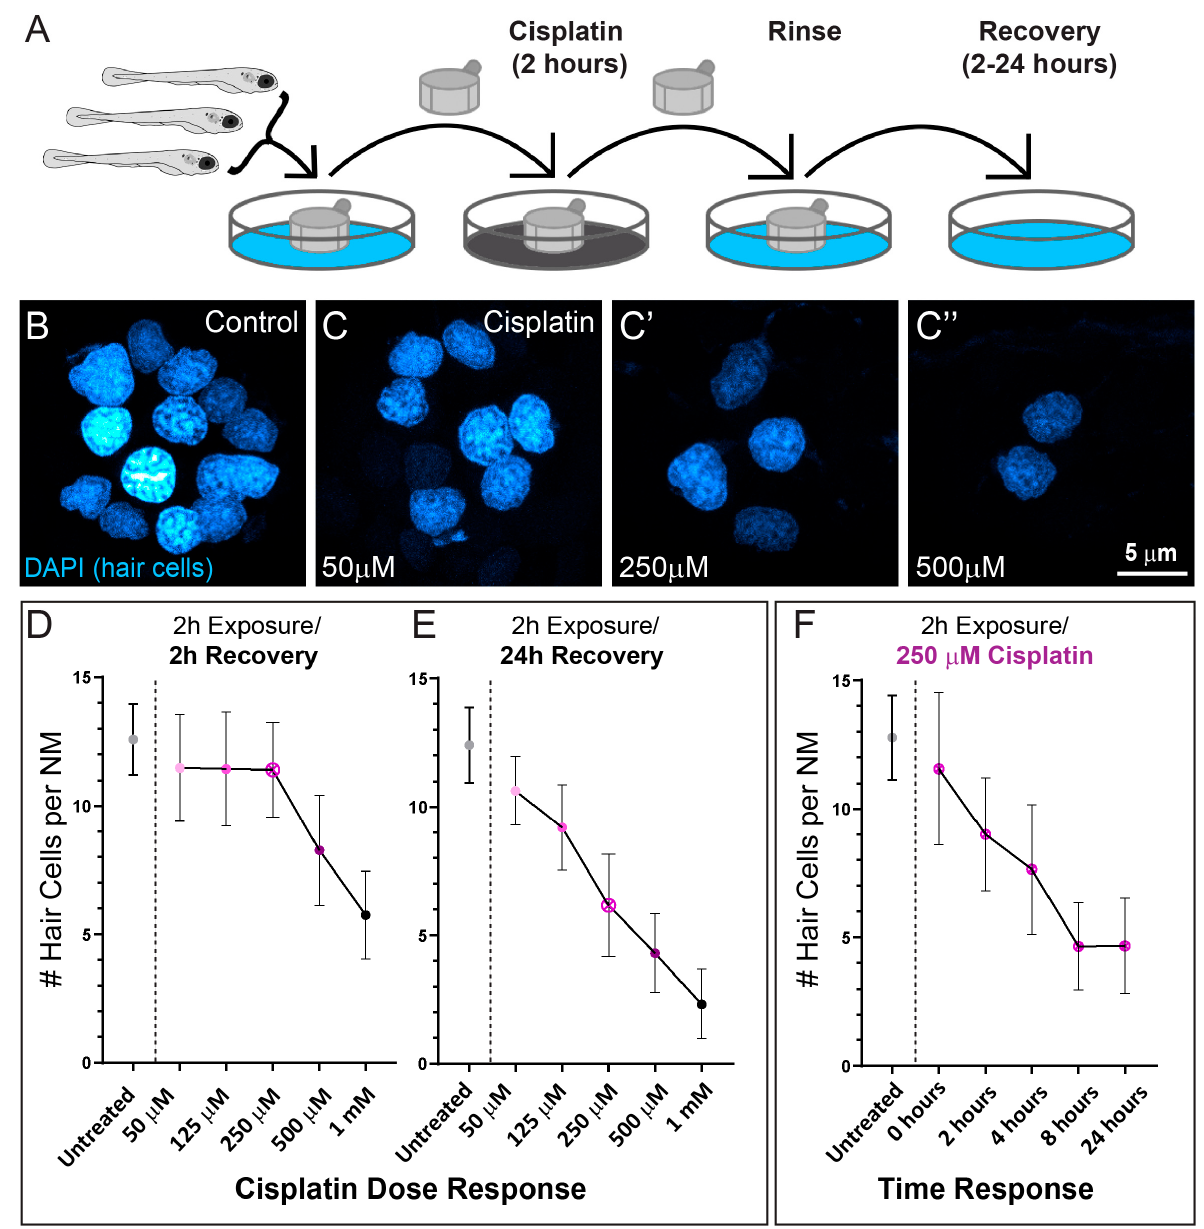
Figure 1. Dose- and time- response relationships of lateral line hair cell loss following 2 h exposure to cisplatin. ( A ) Diagram of standardized larval zebrafish cisplatin exposure protocol. Larvae (6 dpf) were placed into cell strainers and moved between cisplatin exposure and EM rinse steps, while being allowed to swim freely in EM during recovery. ( B , C ) Maximum intensity projection images of neuromast hair cell nuclei labeled with DAPI in either control ( B ) or cisplatin-treated ( C – C” ) larvae following 24 h recovery. ( D , E ) Cisplatin dose response relationship of hair cell loss per neuromast following either 2 h ( D ) or 24 h ( E ) recovery. Each dot represents the mean number of hair cells from 47–50 neuromasts/3 experimental trials. Note the delay in maximal hair cell loss at all doses examined. ( F ) Time response relationship following exposure to 250 µM cisplatin. Each dot represents the mean number of hair cells from 16–20 neuromasts. Maximal hair cell loss appeared to occur between 4–8 h following cisplatin exposure. Bars = SD.